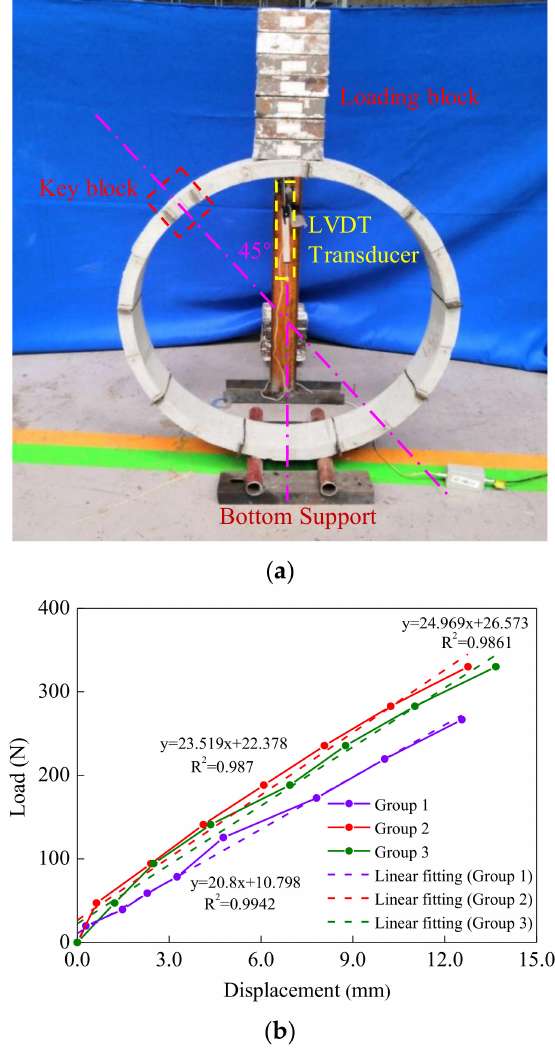
Figure 6. The test of radial stiffness. ( a ) Loading. ( b ) Curves of